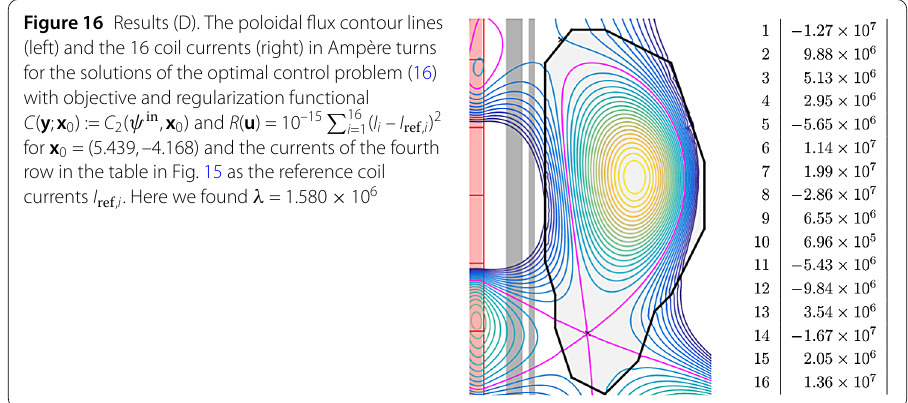
(cid:22) 16 2 i =1 ( I i – I ref , i )